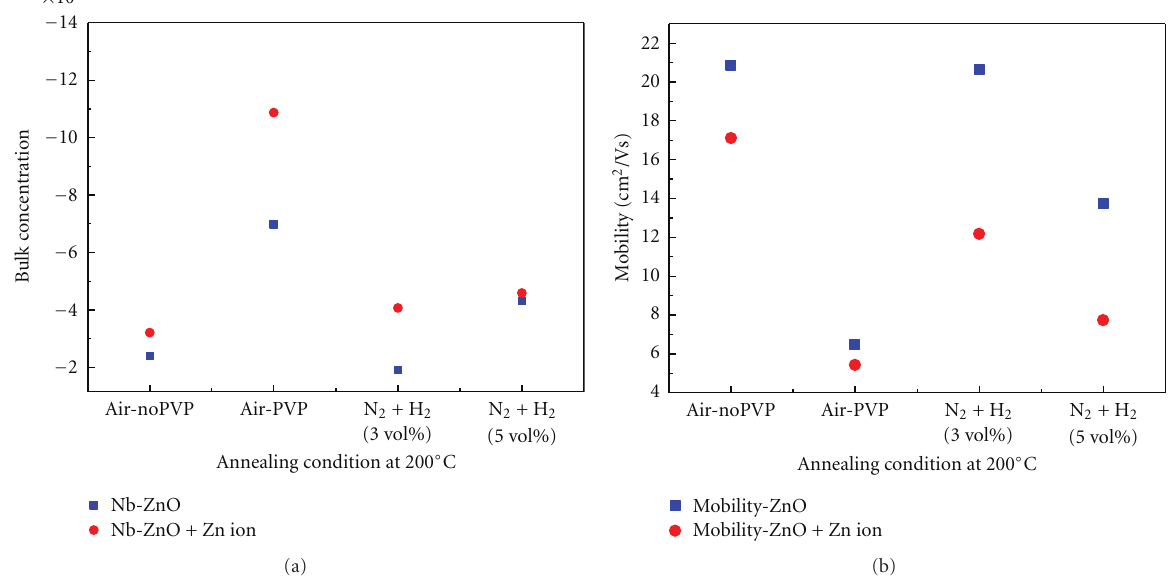
Figure 9: (a) Bulk concentrations and (b) Hall mobilities of the spin-cast ZnO-NPs and ZnO-NPs/Zn 2+ films on gate dielectric.